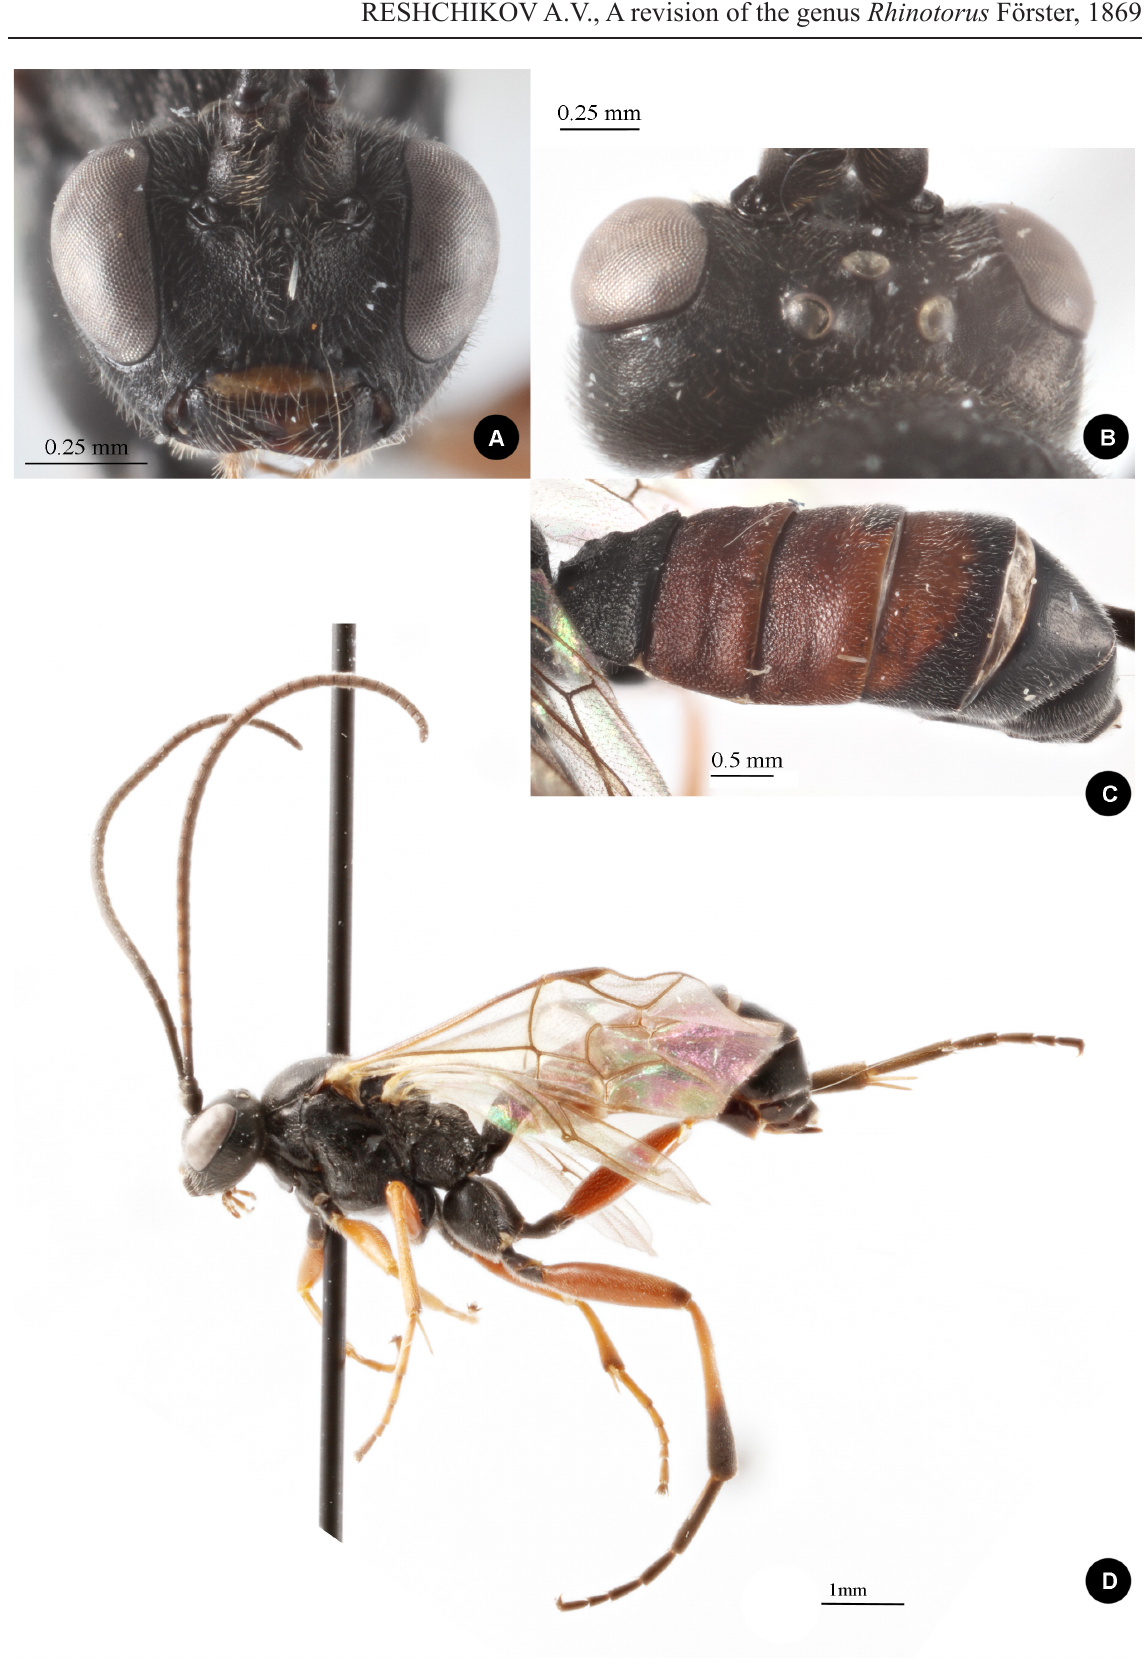
Fig. 13. Rhinotorus tarsilatus sp. nov., holotype, ♀. A . Face. B . Head dorsally. C . Metasoma. D .